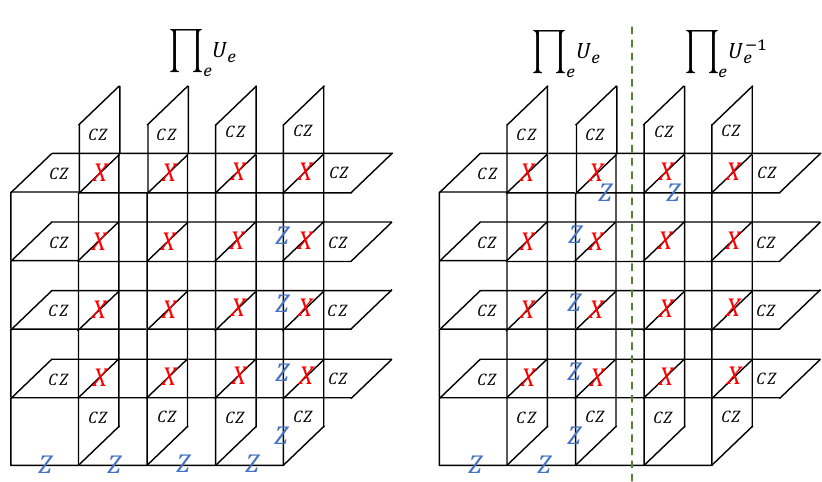
(cid:81) U with the orientation reversed on e